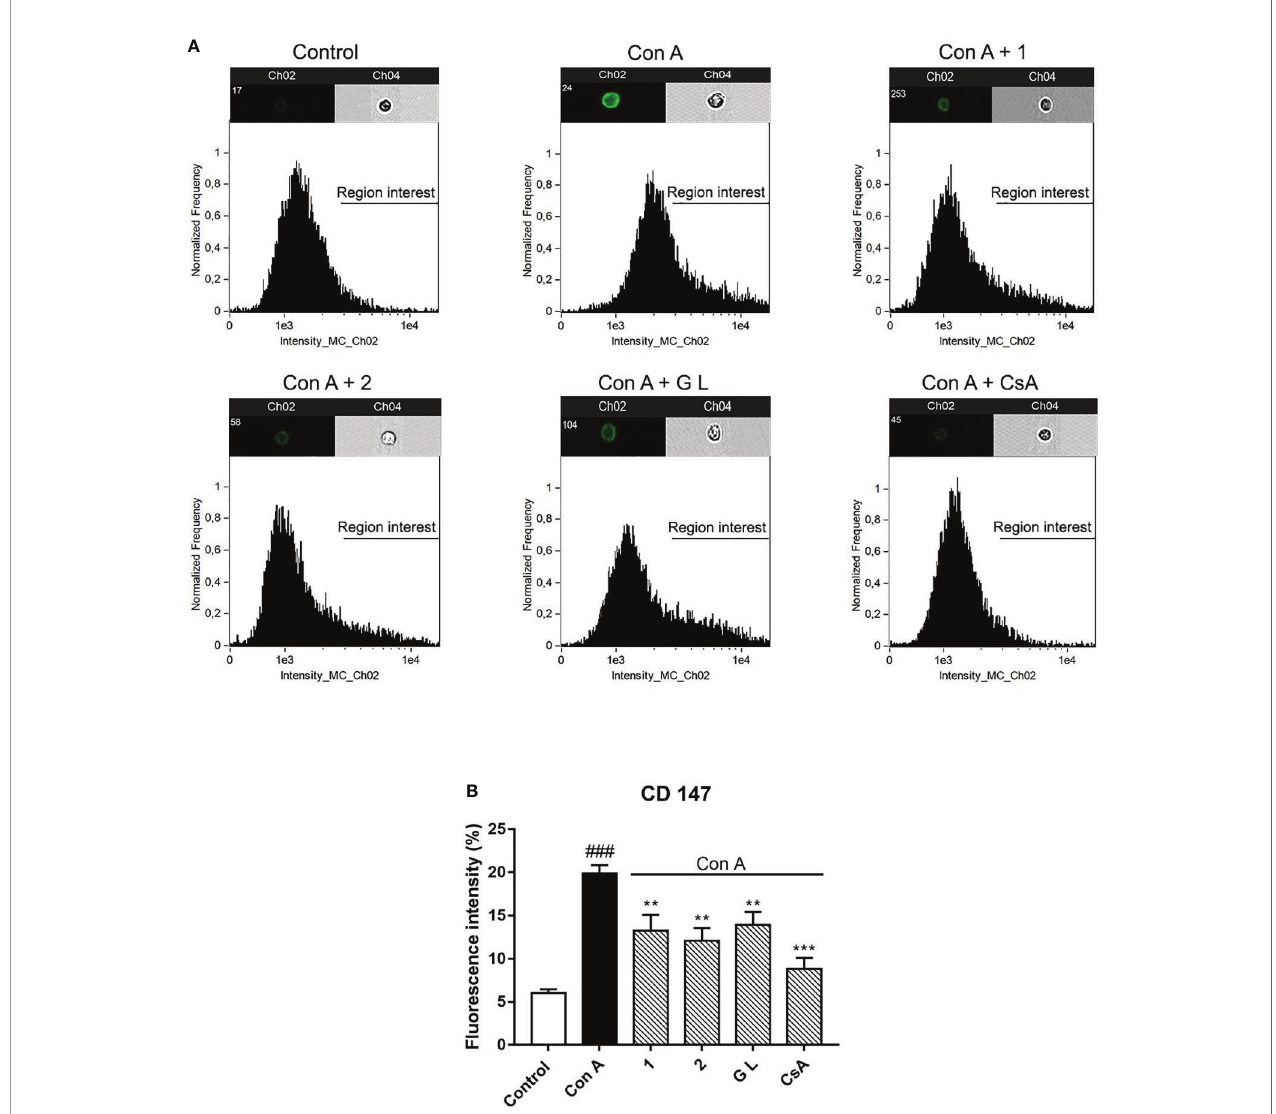
FIGURE 4 | Effect of compounds 1 , 2 , and GraL over plasma membrane levels of CD147 receptor in human T lymphocytes stimulated with Con A Cells were pre-treated with compound 1 , 2 (0.1 µM), GraL (1 m M) or CsA (0.2 µM) for 2 h and then were stimulated with Con A (50 m g/mL) for 48 h. Representative cellular images of the expression of plasma membrane CD147 receptor: bright fi eld images are shown in channel 4 and FITC intensity images are presented on channel 2 (A) . Histogram of the expression of plasma membrane CD147 receptor (B) . Data are the result of average ± SEM (n = 3). The values are shown as the difference between cells treated only with Con A and compared to cells treated with compounds plus Con A, ** p < 0.01 and *** p < 0.001. Values of cells treated with Con A were compared with control cells, ### p < 0.001. One-way ANOVA test with Dunnet ’ s post hoc analysis and Student´s t-test were used for statistical